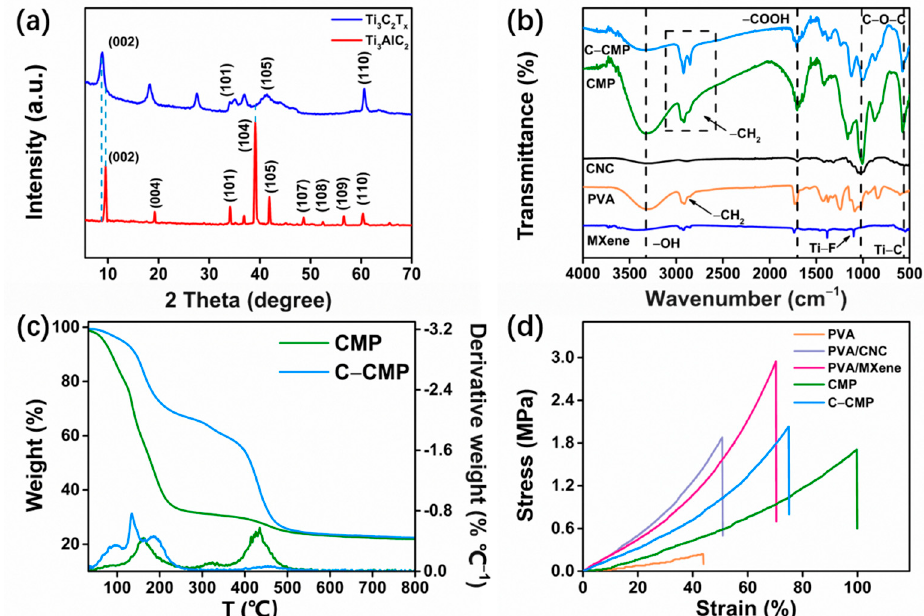
Figure 2. ( a ) X − ray diffraction (XRD) spectra of Ti 3 AlC 2 and Ti 3 C 2 T x . ( b ) Fourier transform infrared (FT − IR) spectra of Ti 3 C 2 T x MXene, polyvinyl alcohol (PVA), cellulose nanocrystals (CNC), un- cross − linked CNC/MXene/PVA (CMP) composite foam and C − CMP. ( c ) Thermogravimetry analy- sis/derivative thermogravimetry (TGA/DTG) curves of CMP and C − CMP composite foams. ( d ) Stress − strain curves of PVA, PVA/CNC, PVA/MXene, CMP and C − CMP foams.